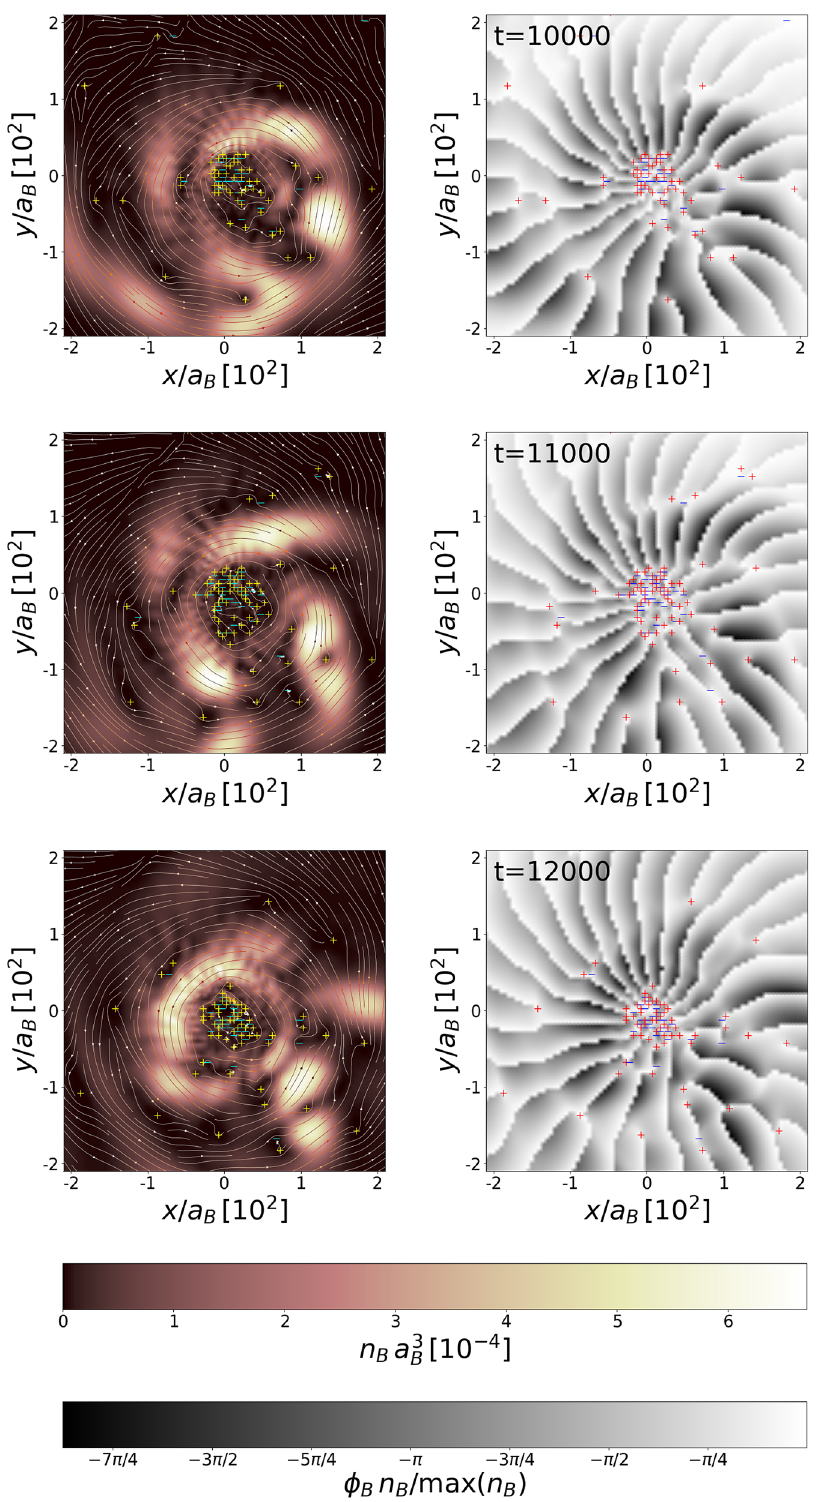
Figure 5. Density with streamlines (left frames) and the phase (right frames) of the bosonic accretion disk at different times, increasing from top to bottom. The unit of time is ( m B a position. The quantized vortices are visible as plus and minus signs present within the matter spiraling around the black hole, at the inner and outer edges of the matter spout, as well as in the region of low